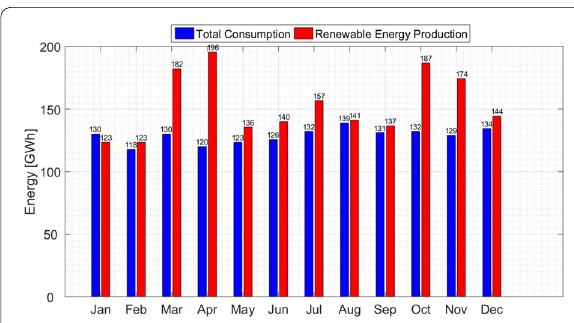
Fig. 21 Estimated total renewable energy emission and monthly consumption for 2018 in Corvo